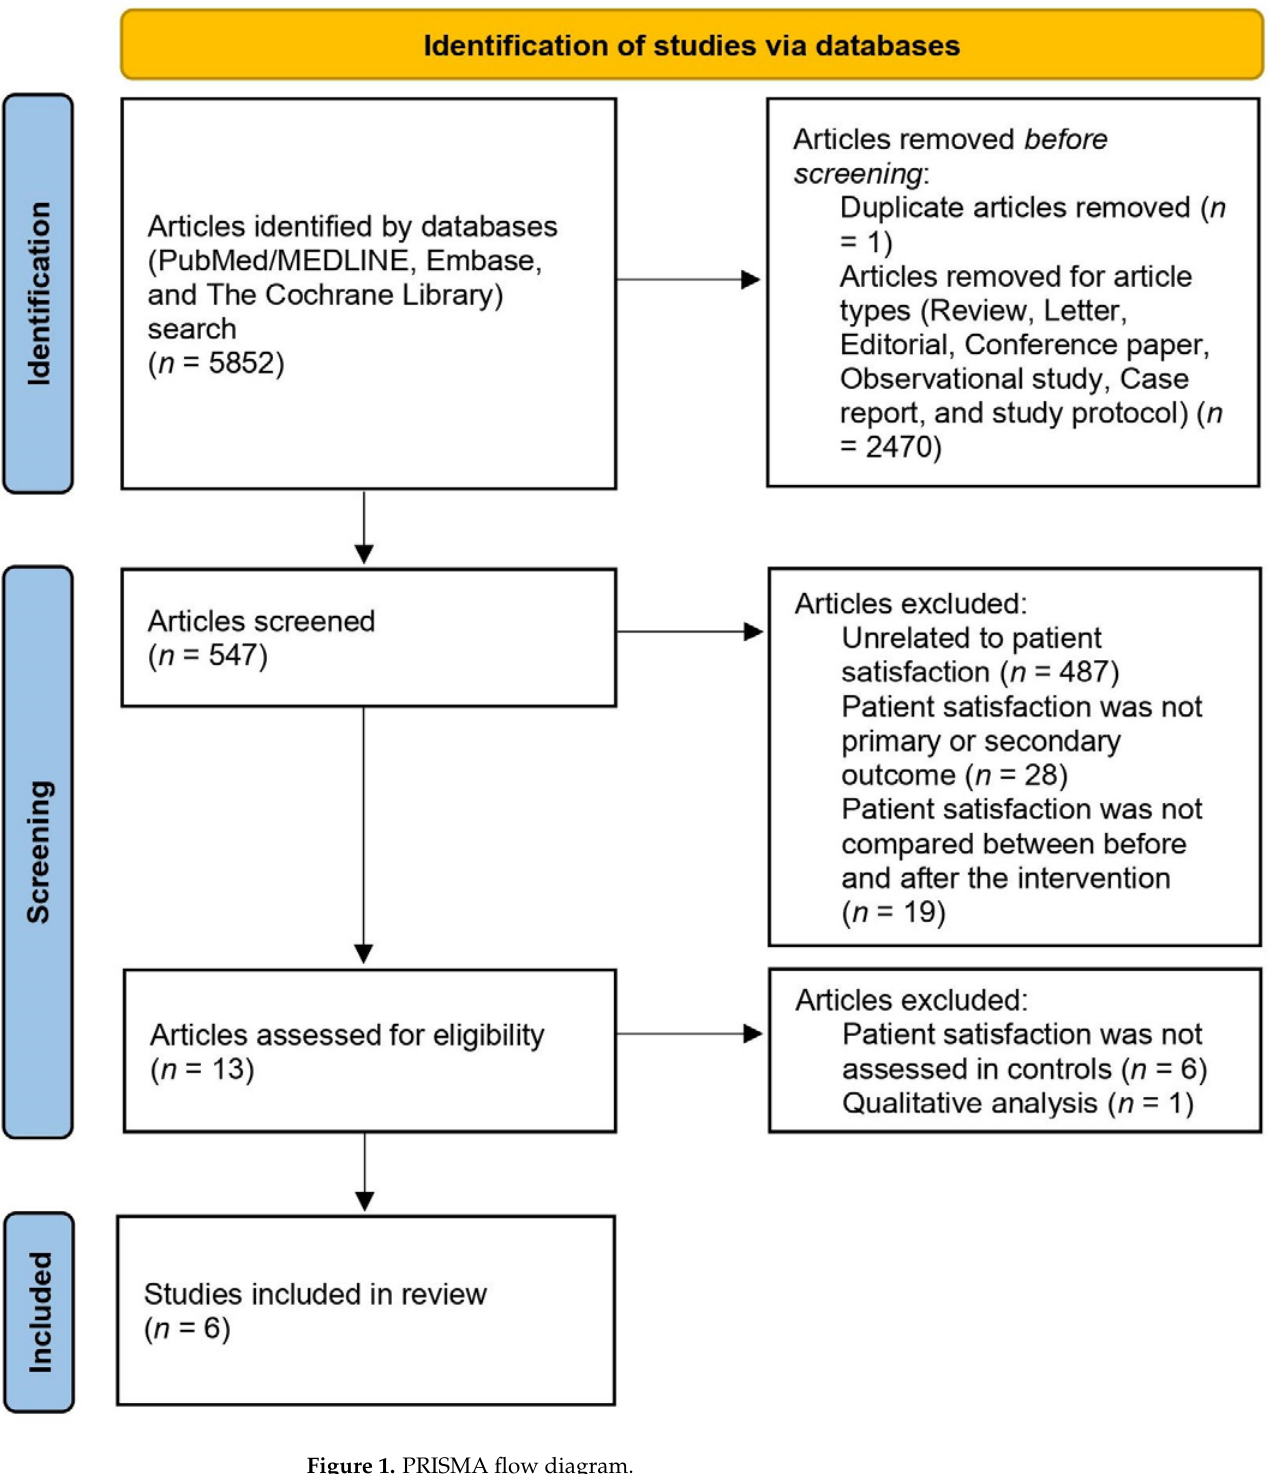
Figure 1. PRISMA flow